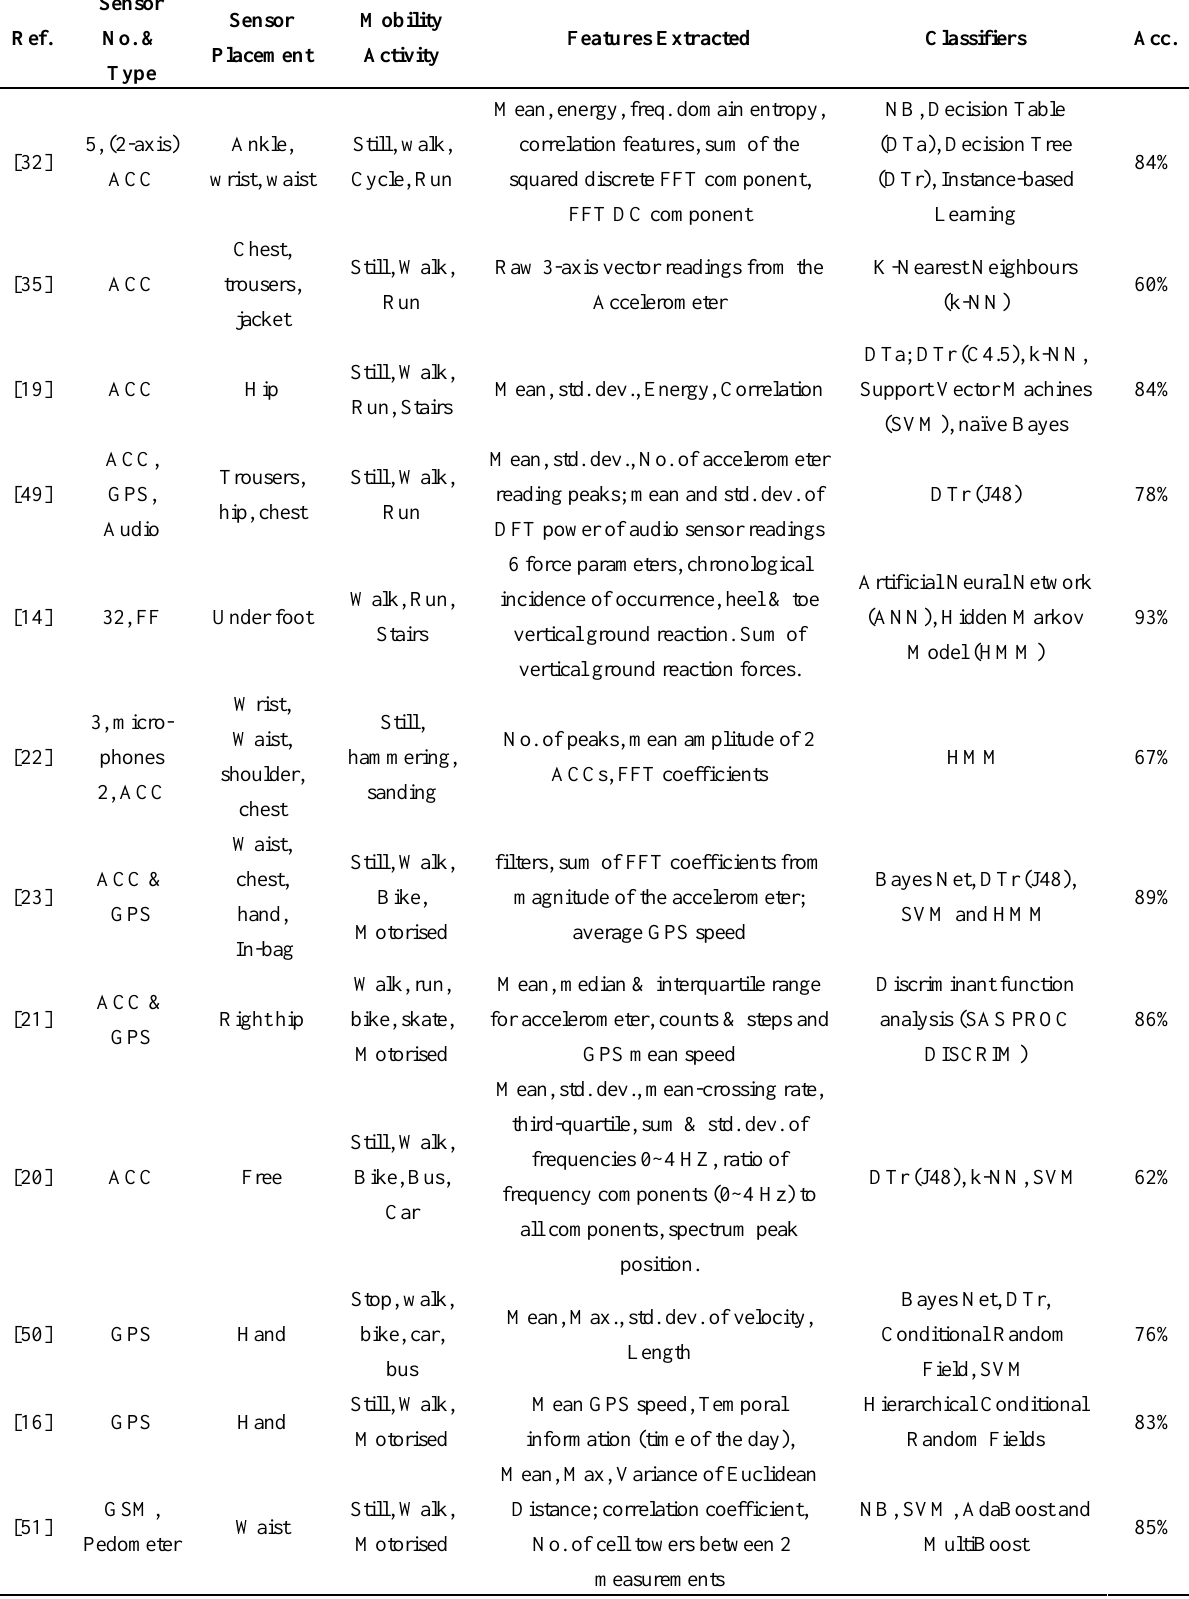
Table 1. Classification of related work concerning user activity recognition.